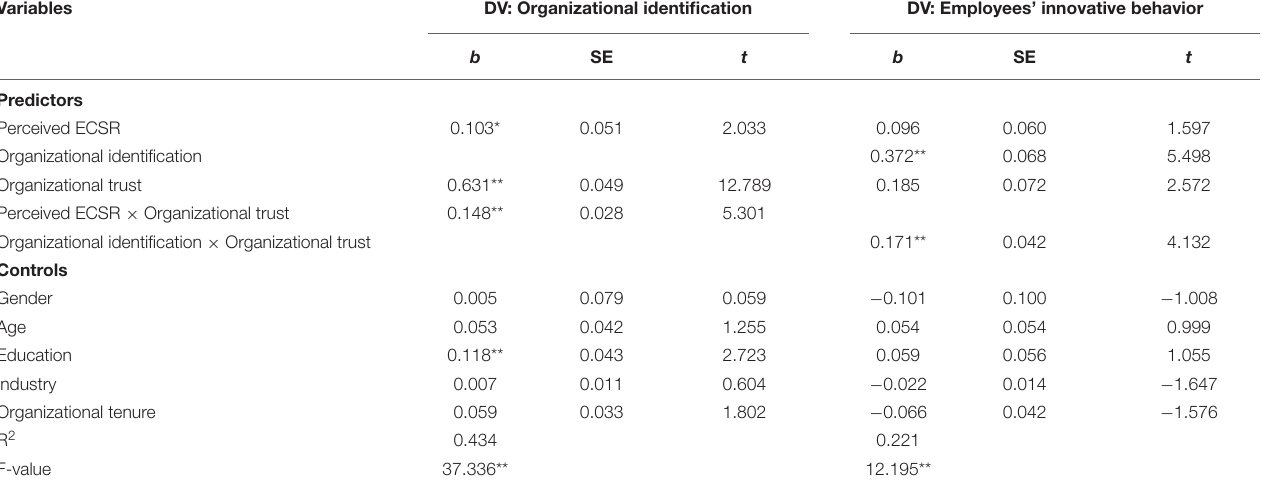
TABLE 4 | Hierarchical regression analysis results.